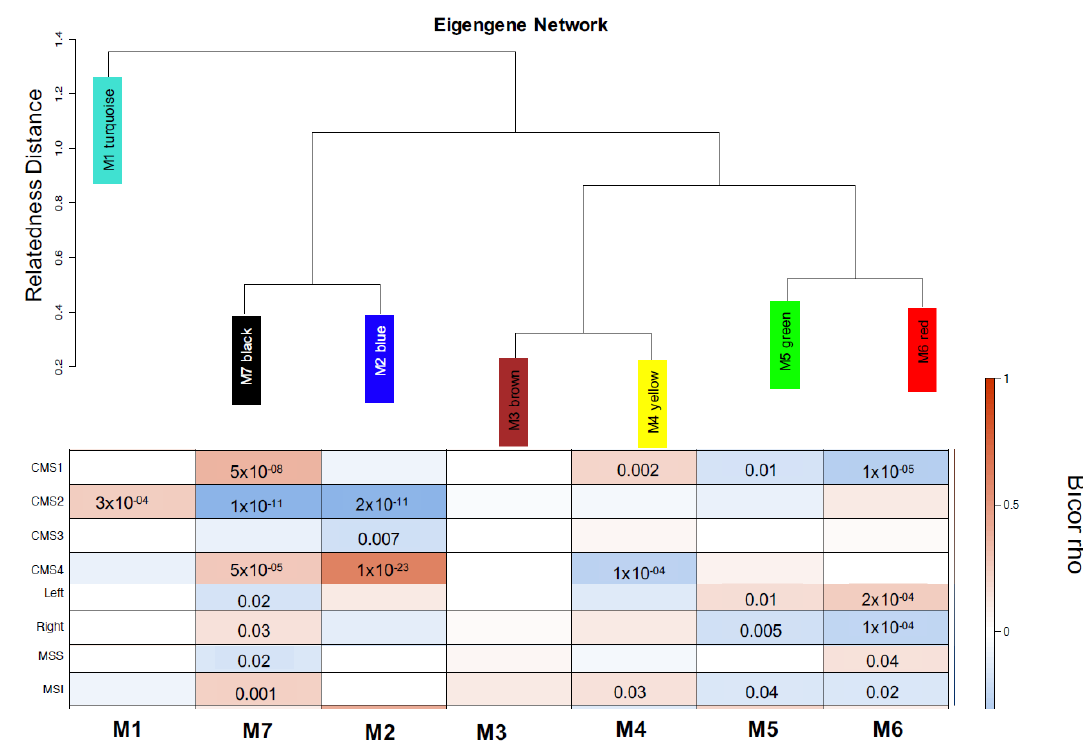
Figure 4. (Top) Hierarchical clustering (top) of module eigengenes that represent the modules found in the clustering analysis for Integromics. Eigengenes that were positively correlated are grouped together by branches of the dendrogram. (Bottom) Heatmap plot of the adjacencies in the eigengene network including the trait weight. Each row and column in the heatmap correspond to one module eigengene (labeled by color) or weight. In the heatmap, blue color represents low adjacency (negative correlation), while red represents high adjacency (positive correlation).